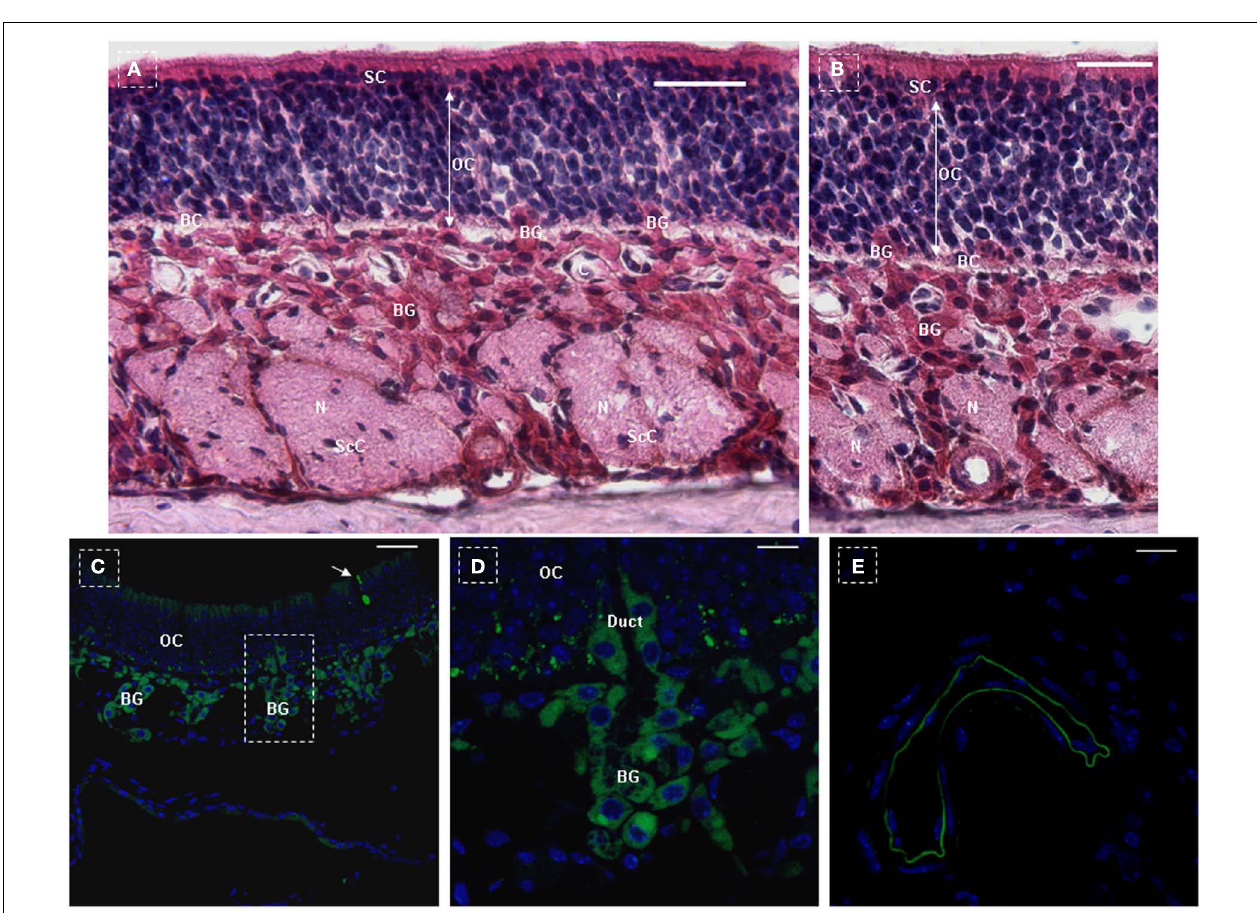
secretions at the surface.The axons of the olfactory cells were ensheathed by Schwann cells to form the prominent olfactory nerves (N).The nuclei observed within the olfactory nerves represented Schwann cell nuclei (ScC). C, capillaries. Immunohistochemical analysis with anti-NTPDase2 detected NTPDase2 expression in SC, Bowman’s gland, and blood vessels (capillaries). After 10days of Dox treatment, GFP expression was observed in SC at the surface of the epithelium and sites close to the basal membrane. (C,D) Meanwhile, GFP expression was found in both the secretory portion of Bowman’s gland and the duct element extending into the epithelium. (C,D) In addition, GFP expression was also observed in the sparse olfactory cells, which extended into the surface of the epithelium [ (C) arrow]. As expected, GFP expression was detected in blood vessels (capillaries). Scale bar: (A,B) , 20 µ m; (C) , 50 µ m; (D,E) , 10 µ